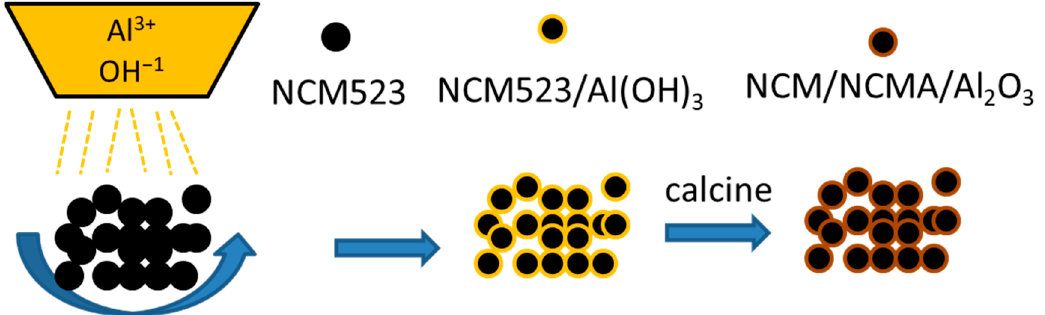
Figure 1. Schematic picture of the facile process for surface coating doping NCM523.